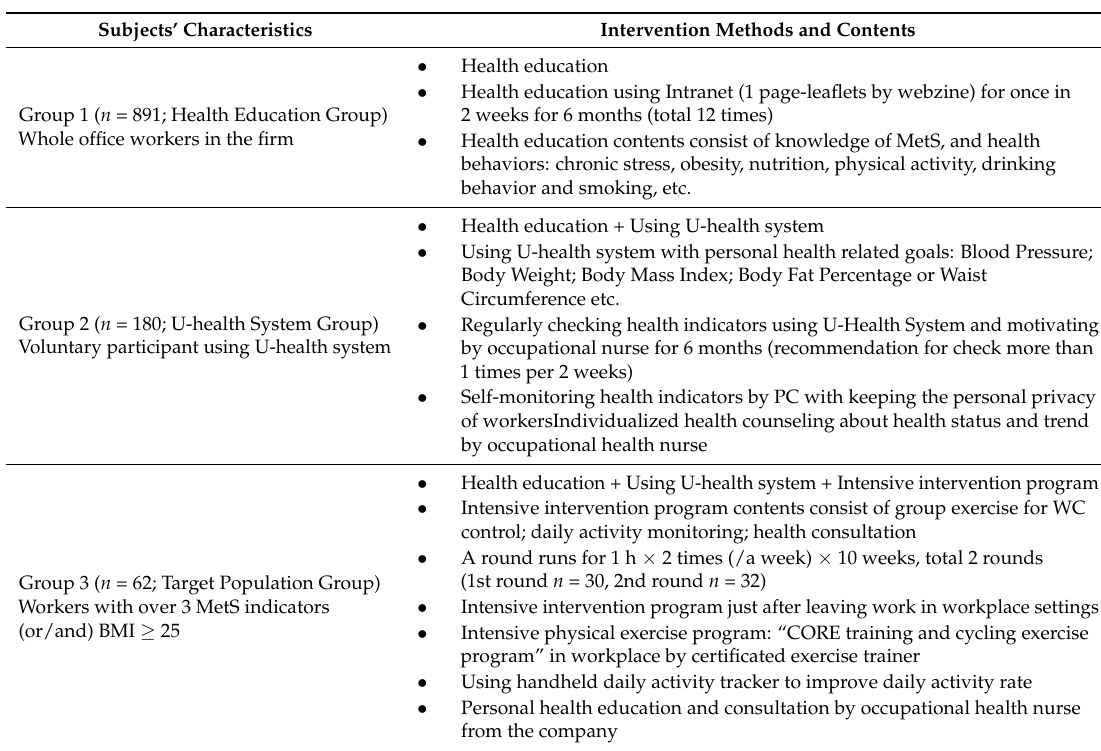
Table 1. Intervention subjects and the methods of the